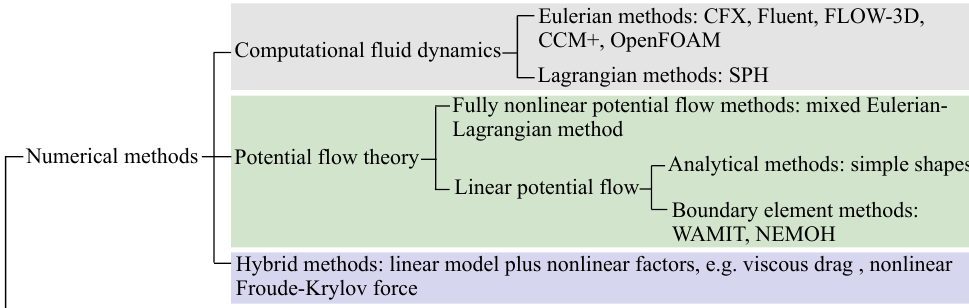
Figure 11. The hydrodynamic modelling methods applied to PA